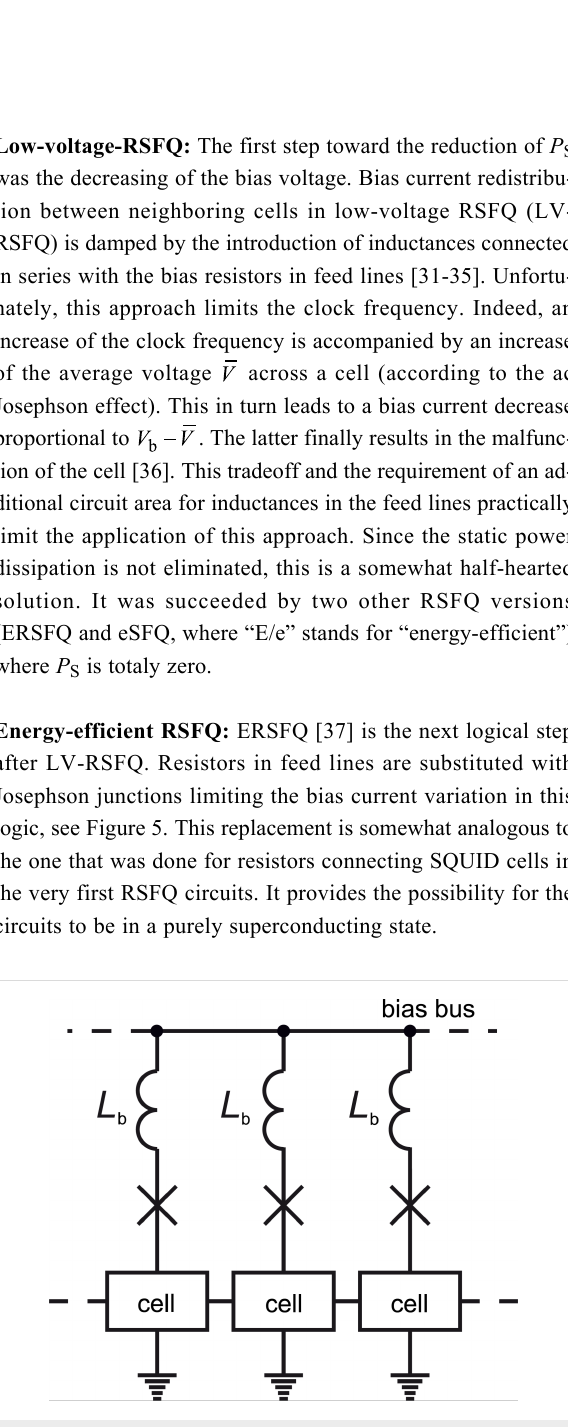
Figure 5: ERSFQ power supply scheme. L b is the inductance limiting the bias current variation.